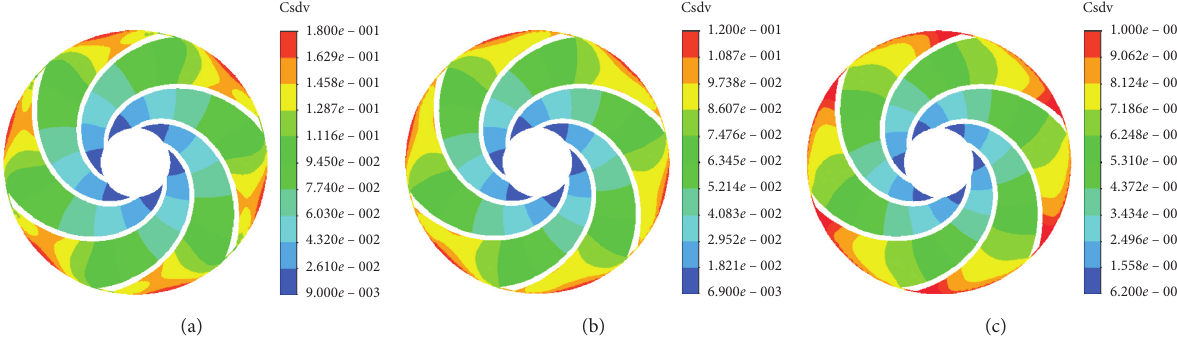
Figure 9: Pressure pulsation intensity distribution in the section of the impeller. (a) 0.8 Q / Q